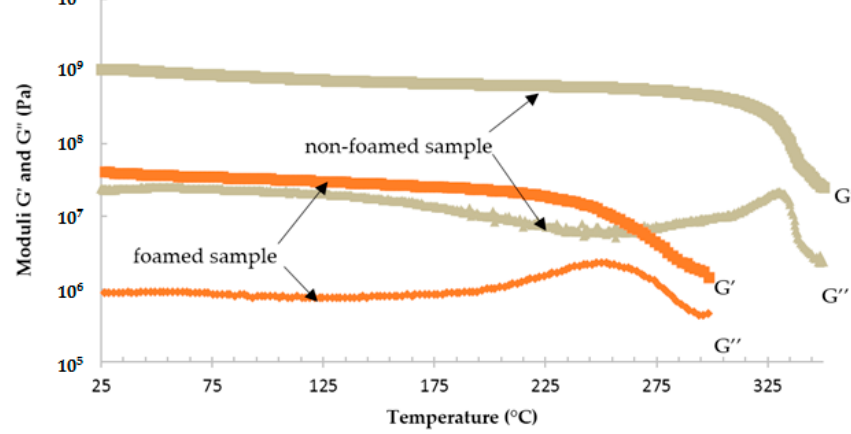
Figure 17. Comparison of rheological analyses of foamed and non-foamed sample, cured according to C 2 cycle.